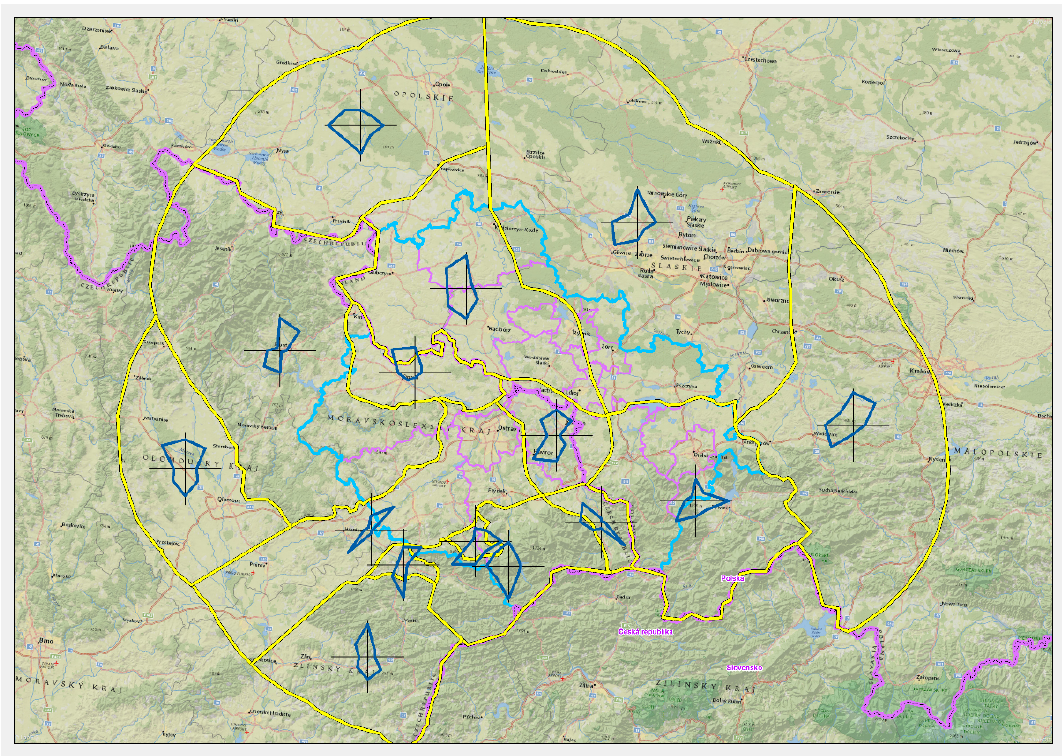
Figure 4. Wind direction probability distribution, (Air Silesia,